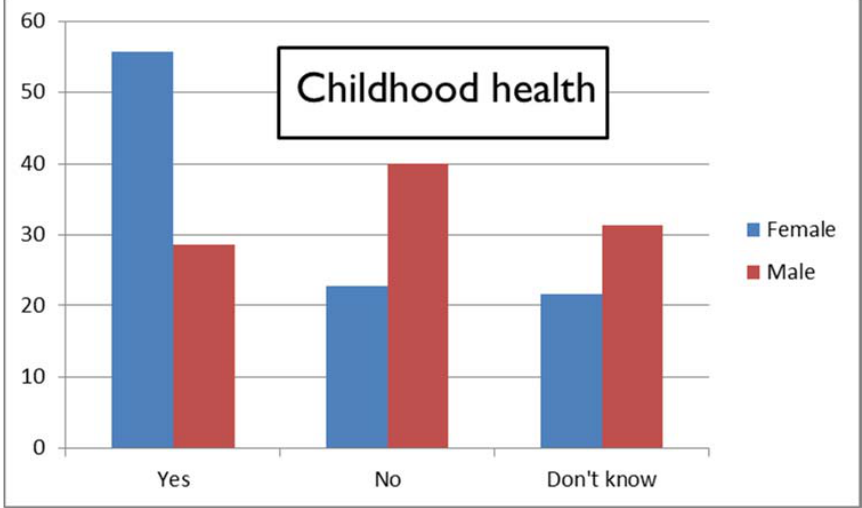
Figure 3. Percentages of female and male respondents giving “Yes”, “No”, and “Don’t know” responses regarding the item on childhood health (NOW responses).